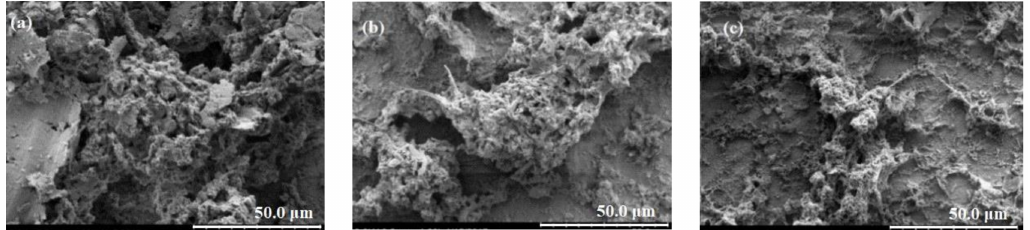
Figure 5. Morphology of biofilm on pipe wall after different durations of shock disinfection. ( a ) Disinfection for 0 min. ( b ) Disinfection for 30 min. ( c ) Disinfection for 60